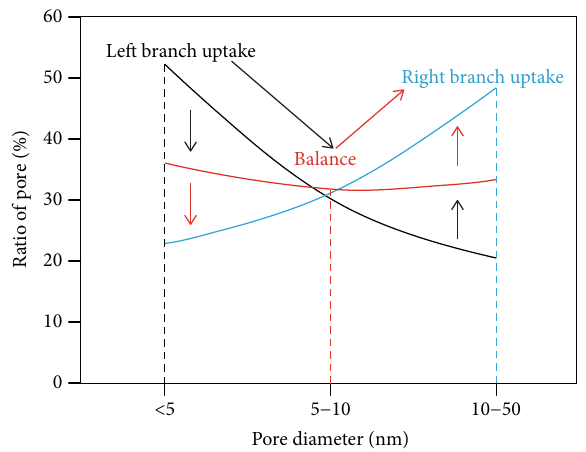
Figure 15: The diagrammatic sketch of the thermal evolution of mesopore structure under various pretreatment